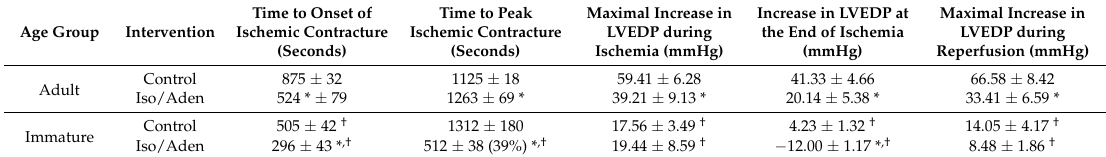
Table 1. Time to key milestones during experimental protocol. Data presented as mean ± SEM.